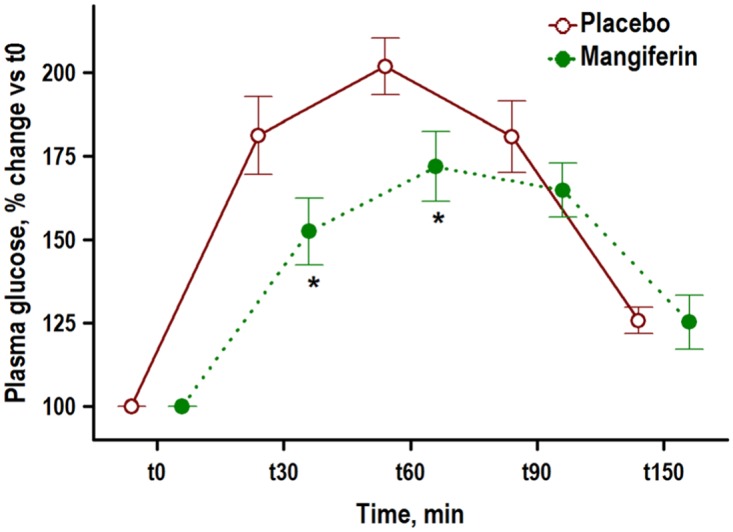
Mangiferin attenuates hyperglycemic response in obese rats after glucose oral administration.Zucker rats with the obese (fa/fa) phenotype (2 months old) were treated with placebo or mangiferin (15 mg/kg BW/day) for 8 weeks (n = 10 rats/group), and plasma glucose was monitored every 30 minutes after oral glucose administration (2 g/kg BW). Graph shows means ± SD plasma glucose change vs basal levels over time. * P < 0.05 indicates significant differences between Placebo and Mangiferin groups obtained by unpaired Student’s t test.